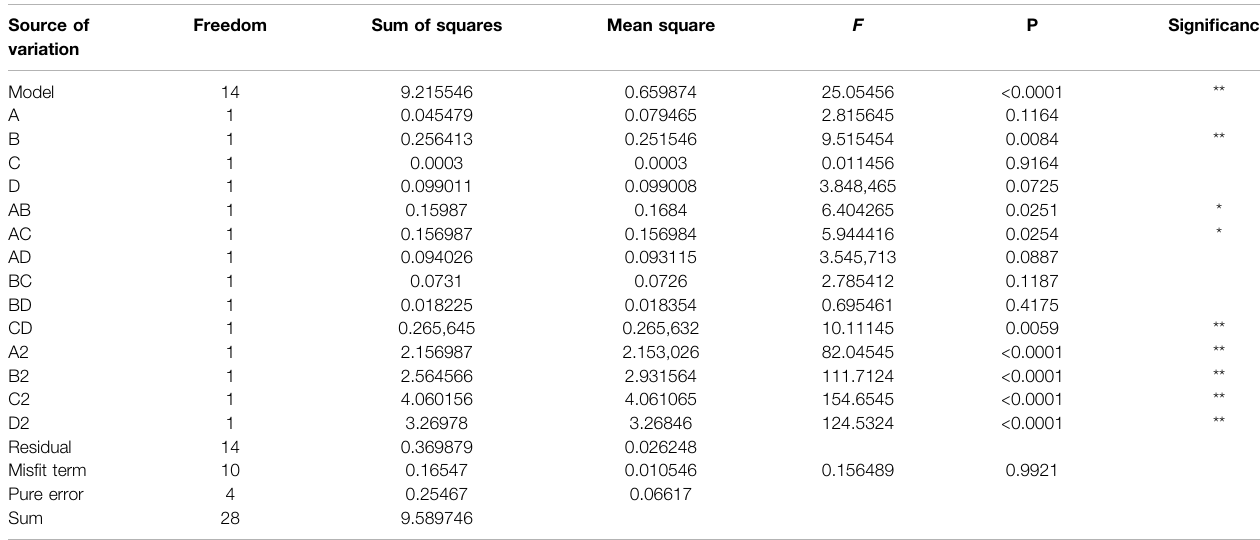
TABLE 2 | Analysis of variance of regression